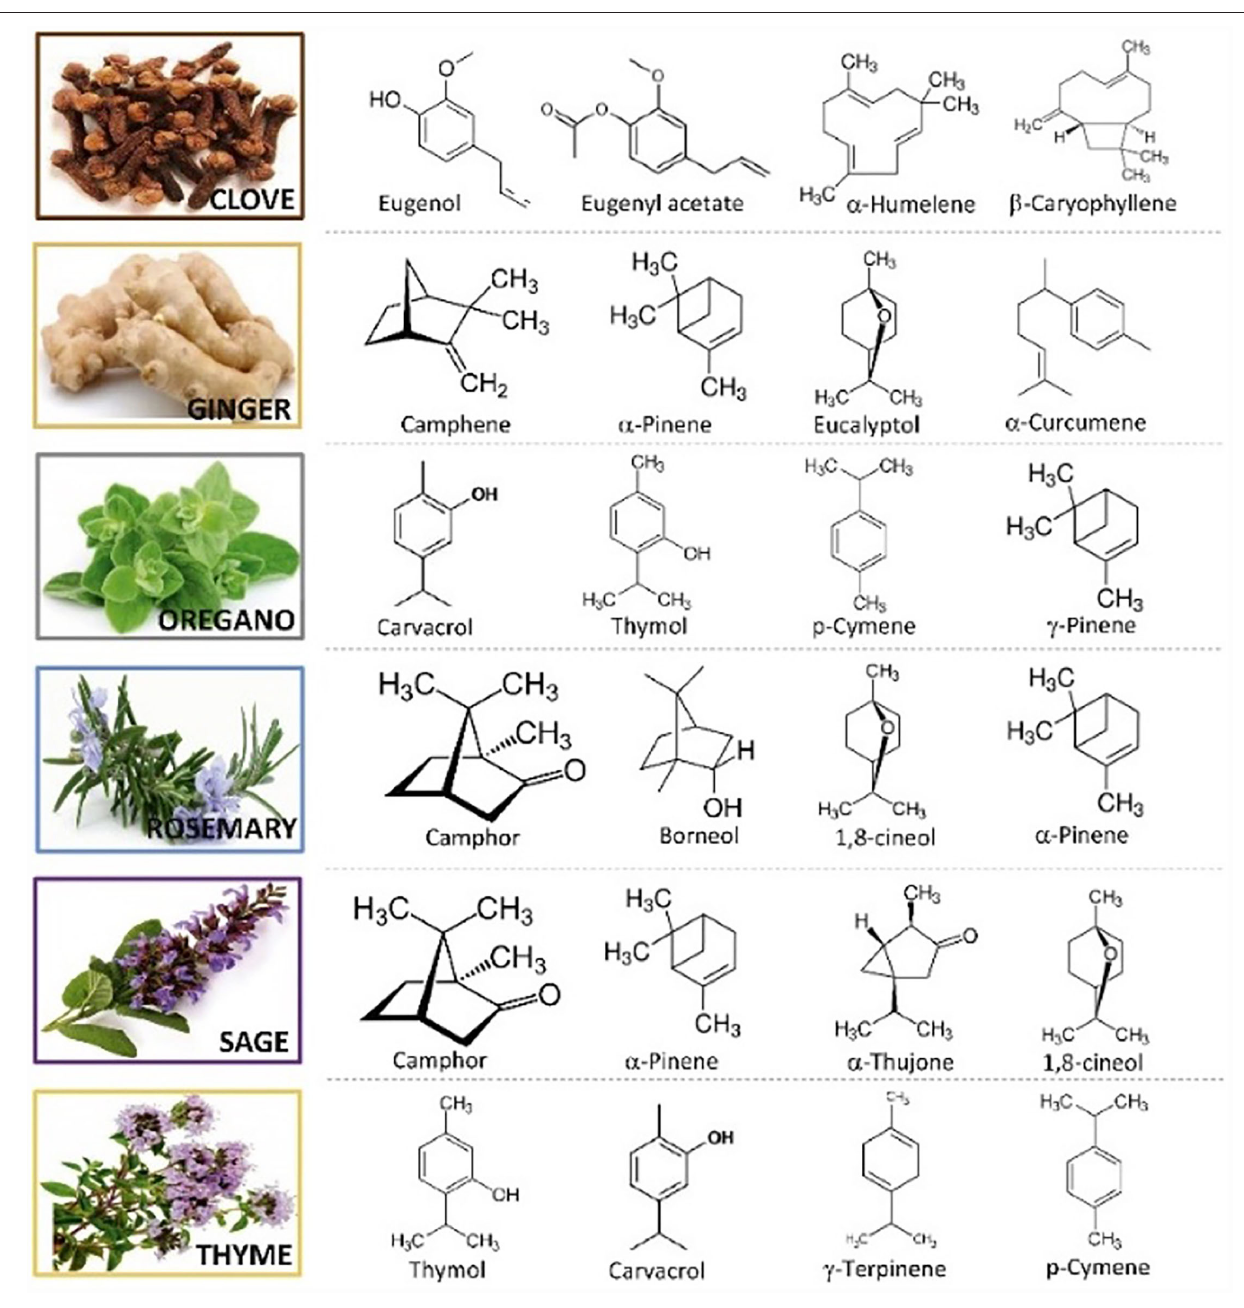
FIGURE 1 | Main antioxidant bioactive compounds found in essential oils